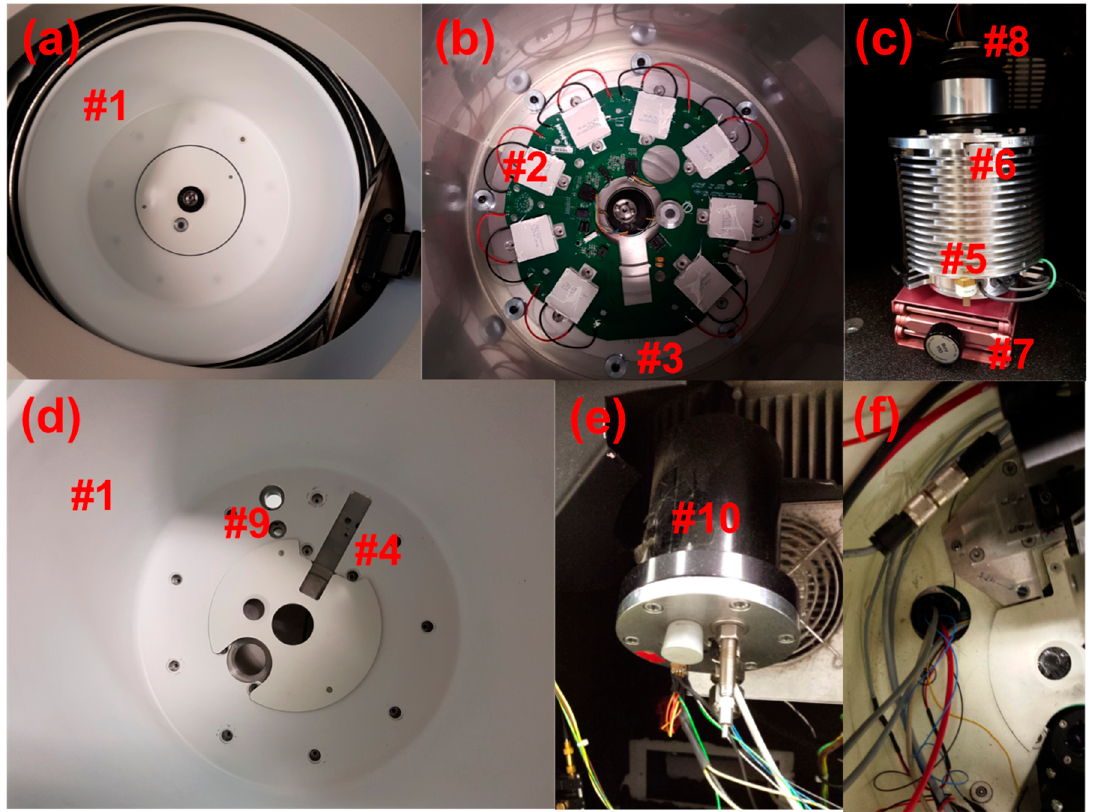
Figure 1. ( a ) Preparative centrifuge chamber; thermal can, chamber lid. ( b ) Preparative centrifuge chamber with the Thermal can removed; thermoelectric elements, heat sink. ( c ) Preparative centrifuge drive; small scissor lift, drive connection nut, drive gasket. ( d ) Preparative centrifuge thermal can with feedthrough holes and slot cut; holes for fiber optic feed through and electrical feedthrough, slot for multiwavelength (MWL) illumination assembly, and extra hole added for installing interferometer optics. ( e ) Custom feedthrough mounting component for repurposing XL-A monochromator hole. ( f ) Wires and fiber optic cables coming through repurposed monochromator hole in XL-A converted open-source multiwavelength analytical ultracentrifugation (MWL-AUC) machine.